Question: State the chart type depicted above.
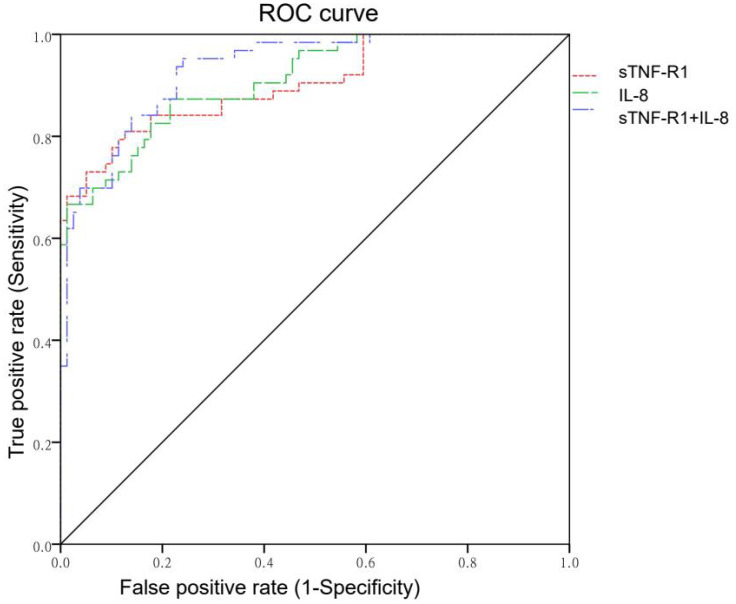
Answer: line